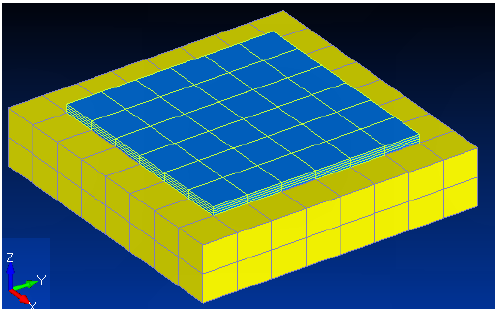
Figure 1. Calibration model with the simplified retina in yellow and the ERM in blue.